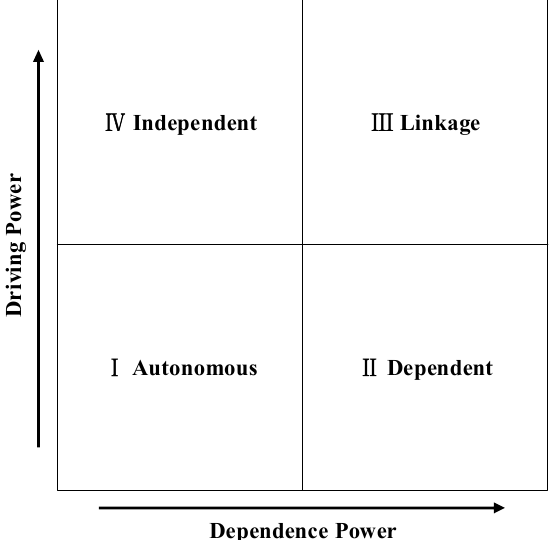
Figure 1. The schematic diagram of the Cross Impact Matrix Multiplication Applied to a Classification (MICMAC) analysis.